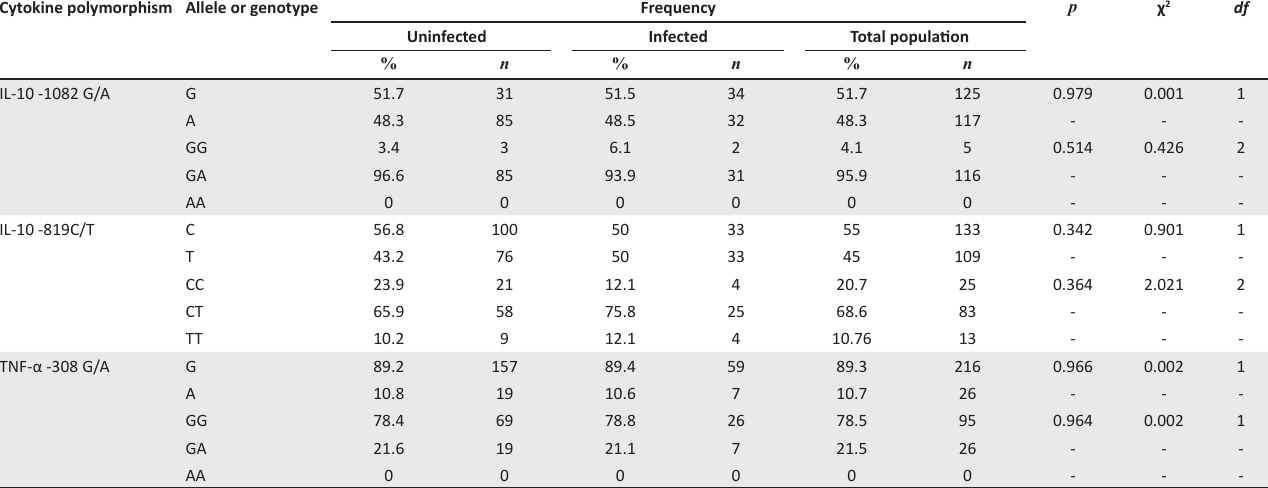
TABLE 3: Distribution of the interleukin-10 -1082, interleukin-10 819 and tumour necrosis factor alpha genotypes and alleles frequencies in uninfected and infected Schistosoma haematobium groups in Bemberi. Cytokine polymorphism Allele or genotype